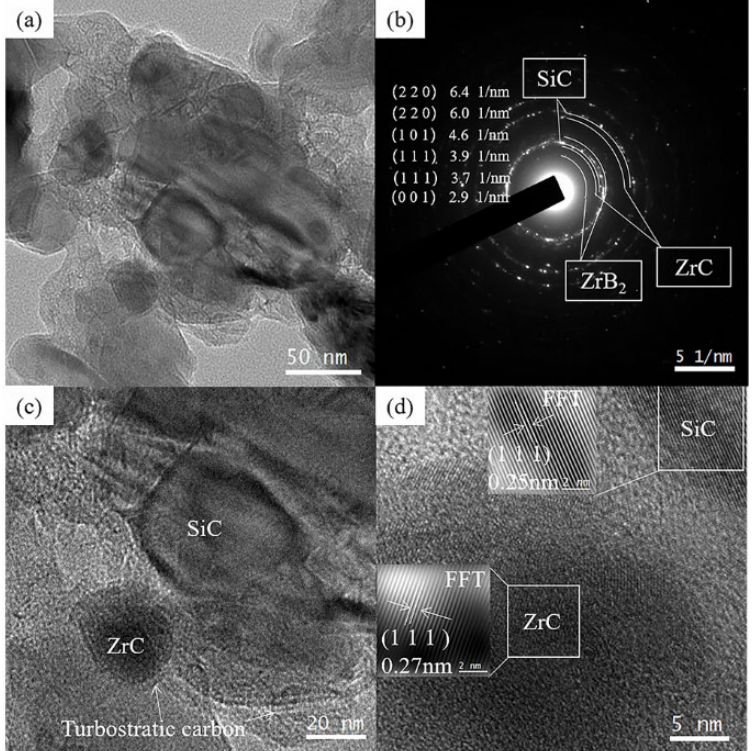
Fig. 8 (a) Bright field image, (b) selected-area electron diffraction, and (c, d) HRTEM images of ABZ-1-drived ceramic annealed at 1800 ℃ (insets: diffraction patterns obtained by Fourier filtered